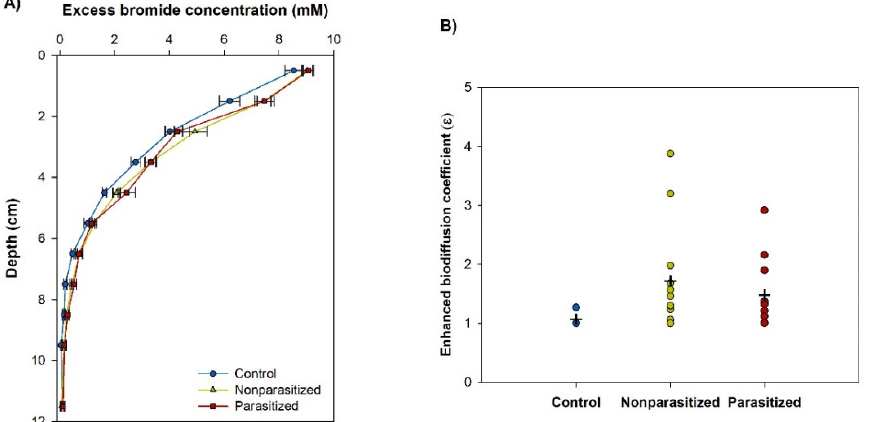
Figure 1. ( A ) Excess bromide concentration profiles in sediment cores (mean ± SE), and ( B ) modeled factor of enhanced biodiffusion ( ε ) (data are represented by points; black crosses correspond to the mean value) following nine days of incubation for the three treatments (“control” ( n = 4), “nonparasitized” ( n = 12), and “parasitized” ( n = 12)).